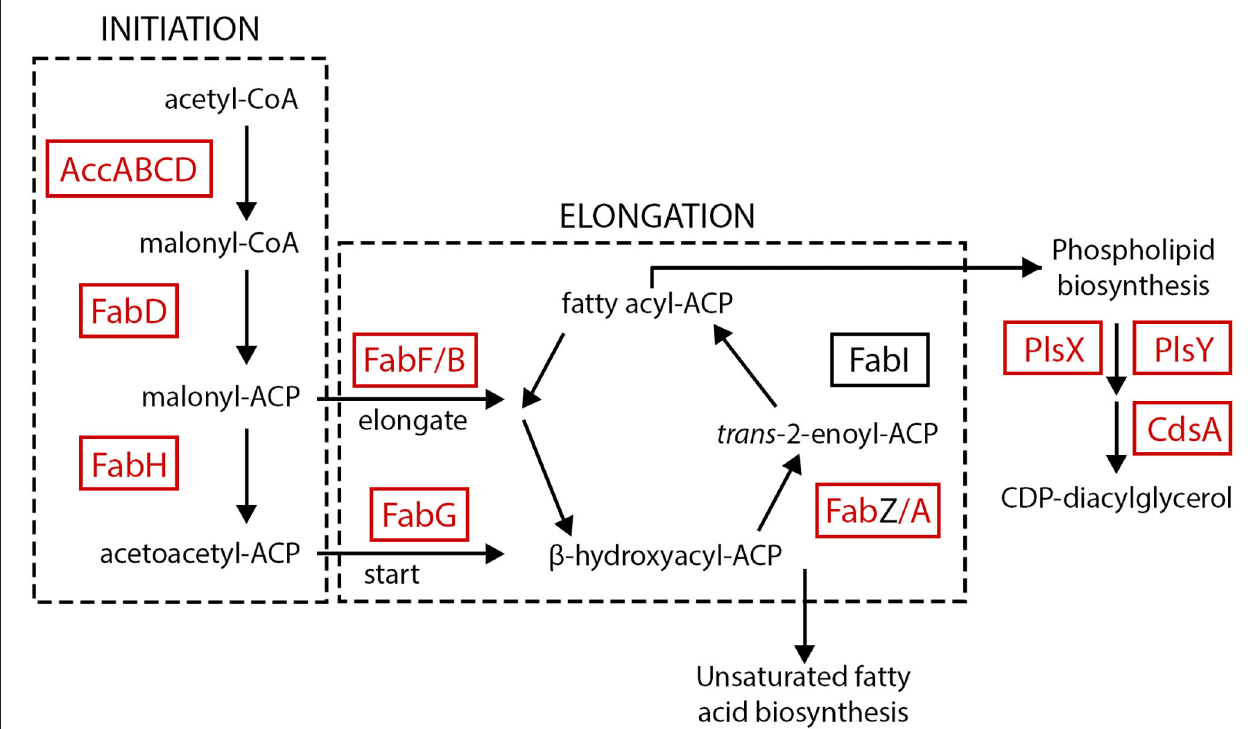
FIGURE 6 | Expression of proteins in the fatty acid biosynthesis pathway. Almost all of the proteins in the fatty acid biosynthesis pathway were increased in AMR strains of both F. tularensis AMR/AMS strain pairs and the Y. pestis AMR/AMS strain pair. Proteins increased in Y. pestis and/or F. tularensis AMR strains are indicated by red text and